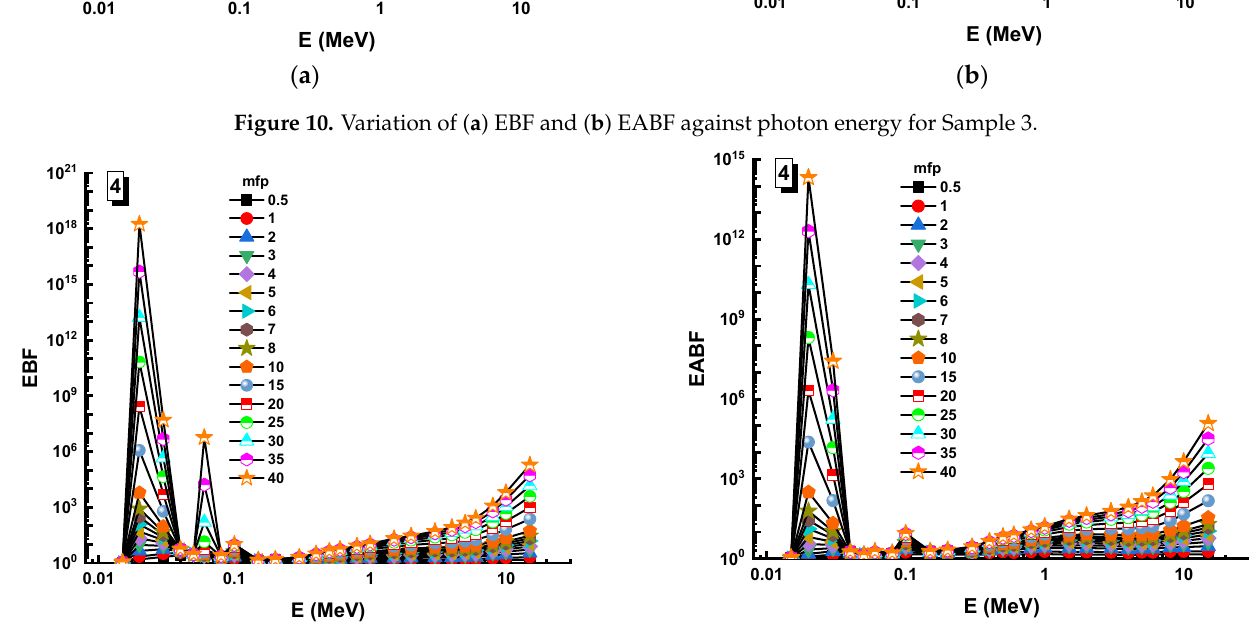
Figure 11. Variation of ( a ) EBF and ( b ) EABF against photon energy for Sample 4.